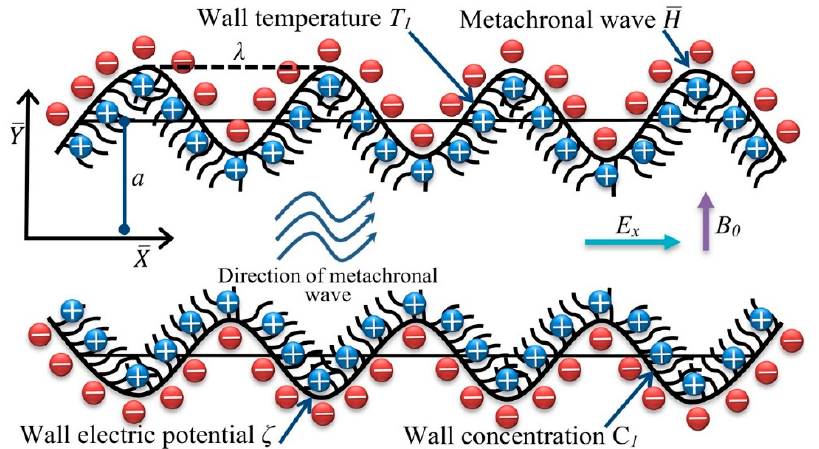
Figure 1. Schematic diagram of the intended flow.